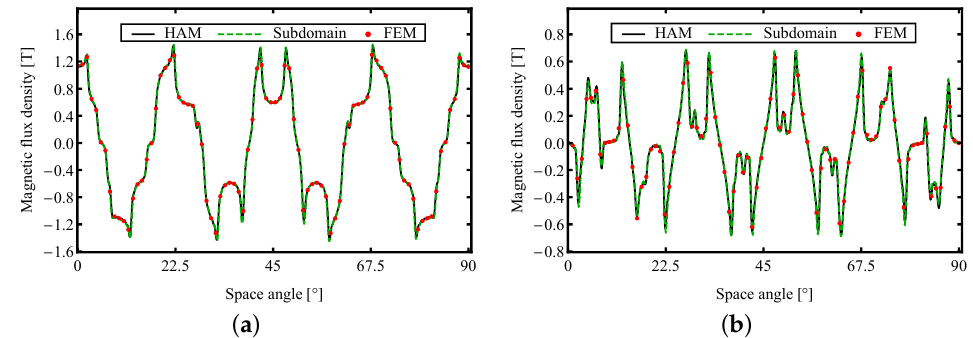
Figure 14. Comparison of the flux density at the middle of the air gap of Machine I in open-circuit condition: ( a ) radial component; ( b ) circumferential component.